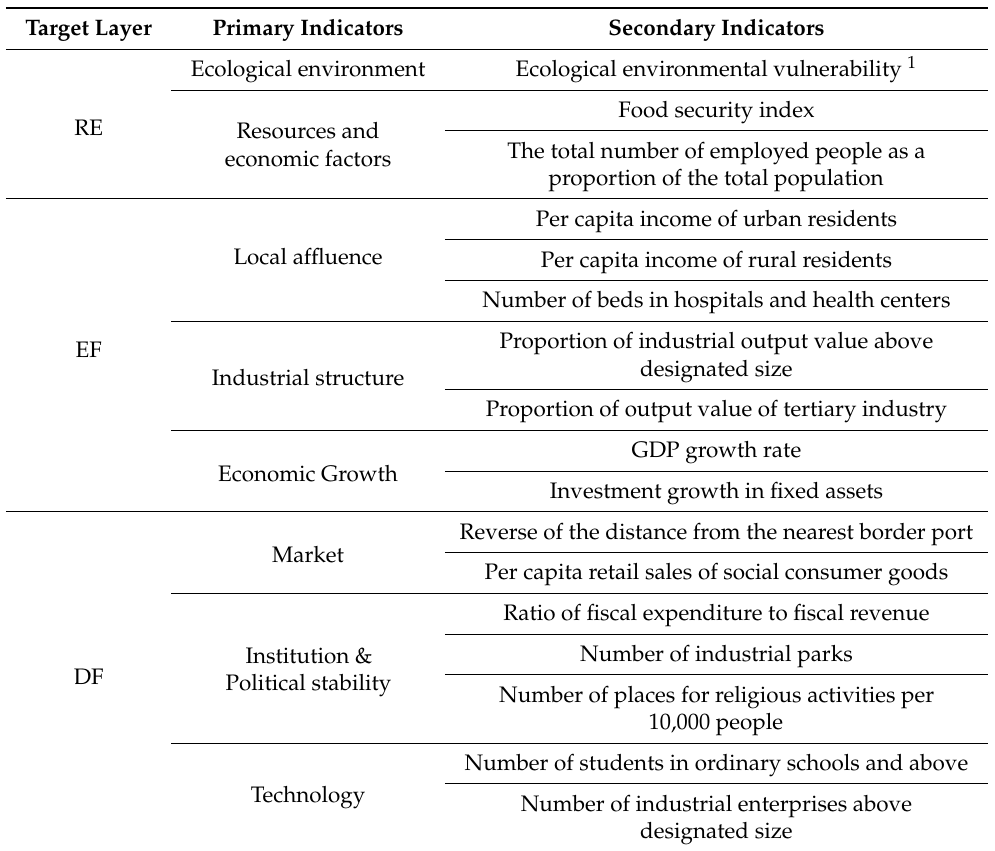
Table 2. RES Indicator System of Qinghai–Tibet